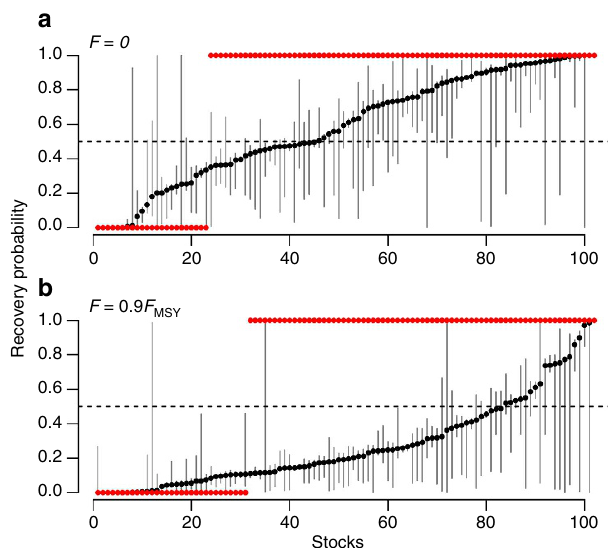
Figure 4 | Consequences of non-stationary productivity for recovery of currently depleted stocks. Shown are recovery probabilities over a 10-year timeline under no fishing ( F ¼ 0; a ) and under fishing at 90% of maximum sustainable yield ( F ¼ 0.9 F MSY ; b ). Black circles indicate probability point estimates; vertical lines display uncertainty, where the lower (upper) limit is assessed as the proportion of trajectories exceeding the 10% (90%) posterior B MSY quantile. For comparison, red circles give the predicted recovery probability for each stock based on the deterministic Graham– Schaefer theory where the intrinsic productivity is fixed at its mean historical value. In the deterministic case, a stock recovers with probability 1 or